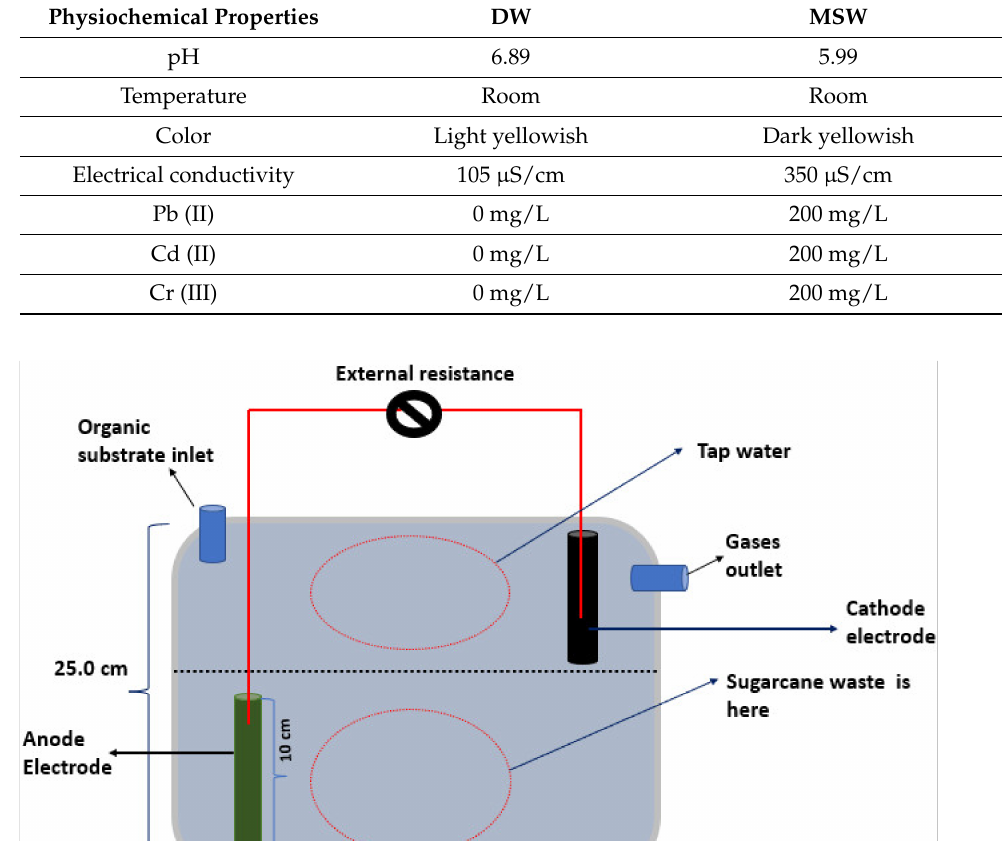
Table 1. The characteristics of the inoculation sources before and after treatment.